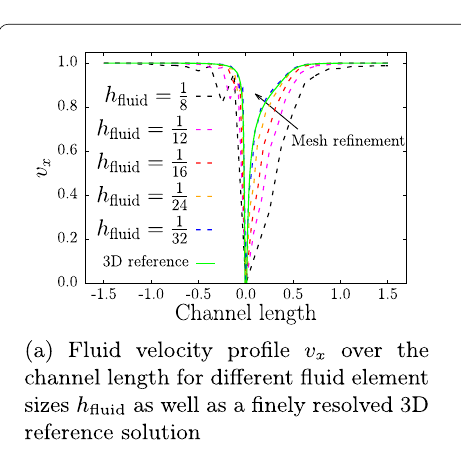
Fig. 10 Dependence of the fluid velocity on the mesh